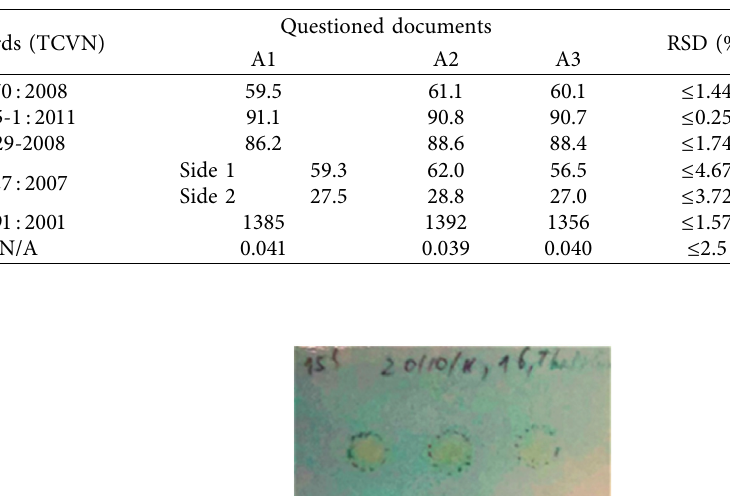
Table 1: Physical characteristics of papers.